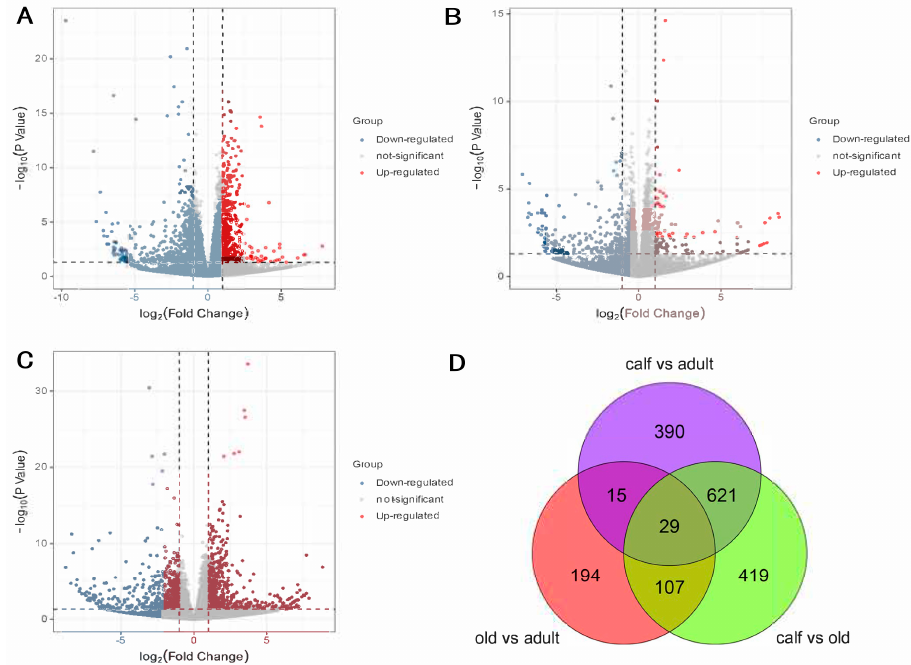
Figure 1. ( A ) volcano plot for DEGs in calf vs. adult. ( B ) volcano plot for DEGs in adult vs. old. ( C ) volcano plot for DEGs in calf vs. old. ( D ) Venn diagram of DEGs in each group.